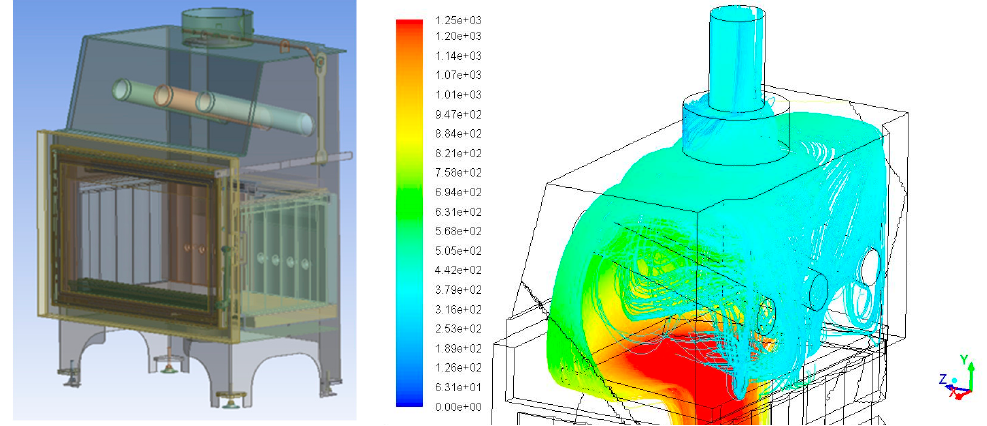
Figure 14. Gas particle paths in the fireplace (Case 3)—temperature scale (°C).